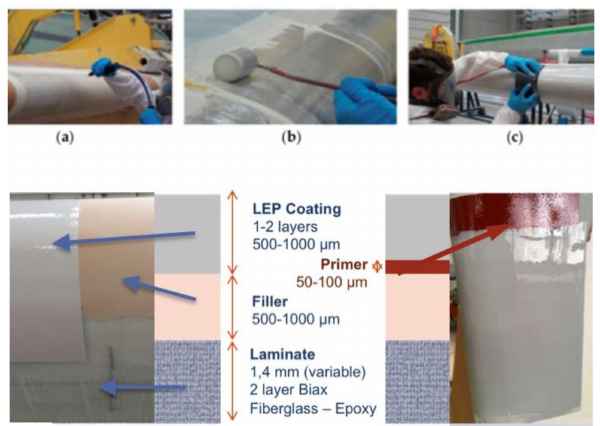
Figure 1. Leading Edge Protection (LEP) system application procedures, i.e., ( a ) spray; ( b ) roller; ( c ) trowel. Multilayer